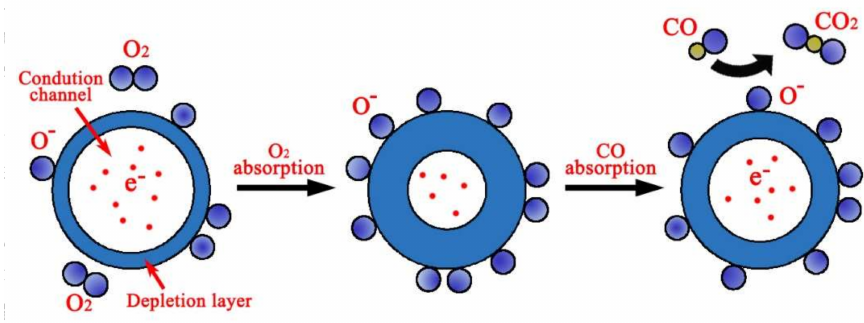
Figure 7. Schematics of ZnO CO sensor sensing